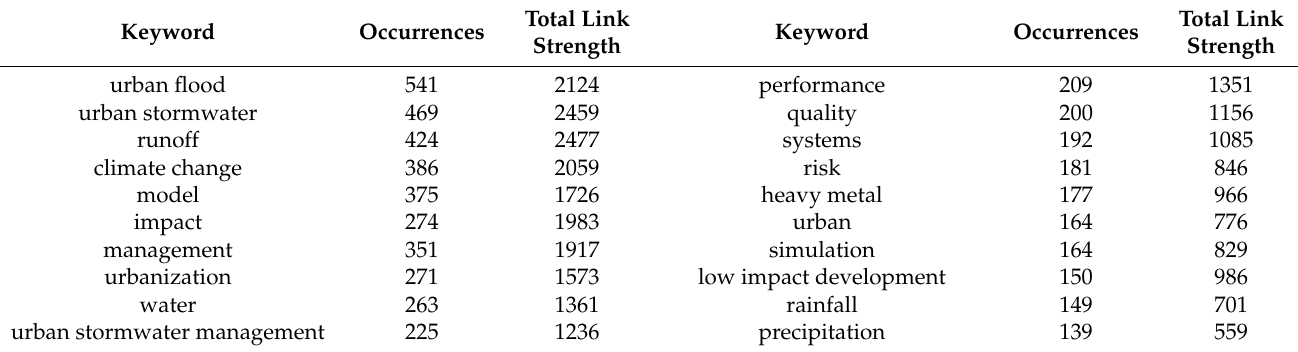
Figure 7. Density and clustering map of co-occurrence keywords in the urban floods field: ( a ) the keyword density map; ( b ) the keyword clustering map. Table 2. The occurrence frequency and total link strength of the top 20